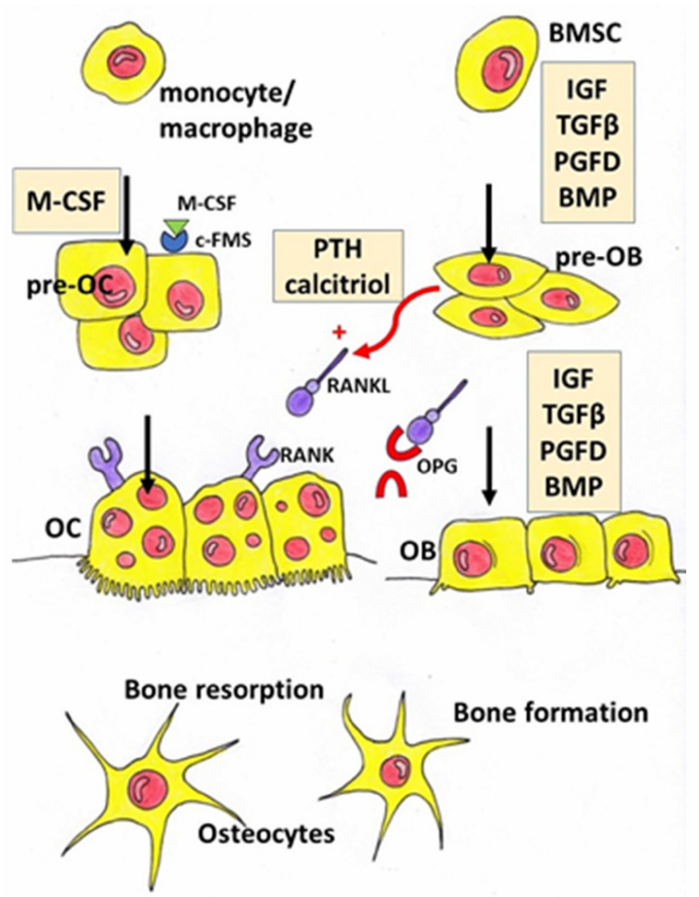
Figure 1. Schematic diagram representing regulation of osteoblast and osteoclast differentiation. BMP—bone morphogenic protein, BMSC—bone marrow-derived mesenchymal stem cells, c-FMS— colony-stimulating factor-1 receptor, IGF—insulin-like growth factor, M-CSF—macrophage colony- stimulating factor, OB—osteoblast, OC—osteoclast, OPG—osteoprotegerin, PGFD—platelet-derived growth factor, pre-OB—pre-osteoblasts, pre-OC—pre-osteoclasts, PTH—parathyroid hormone, RANK—Receptor Activator for Nuclear Factor κ B, RANKL—Receptor Activator for Nuclear Factor κ B Ligand, TGF β —tumour growth factor β